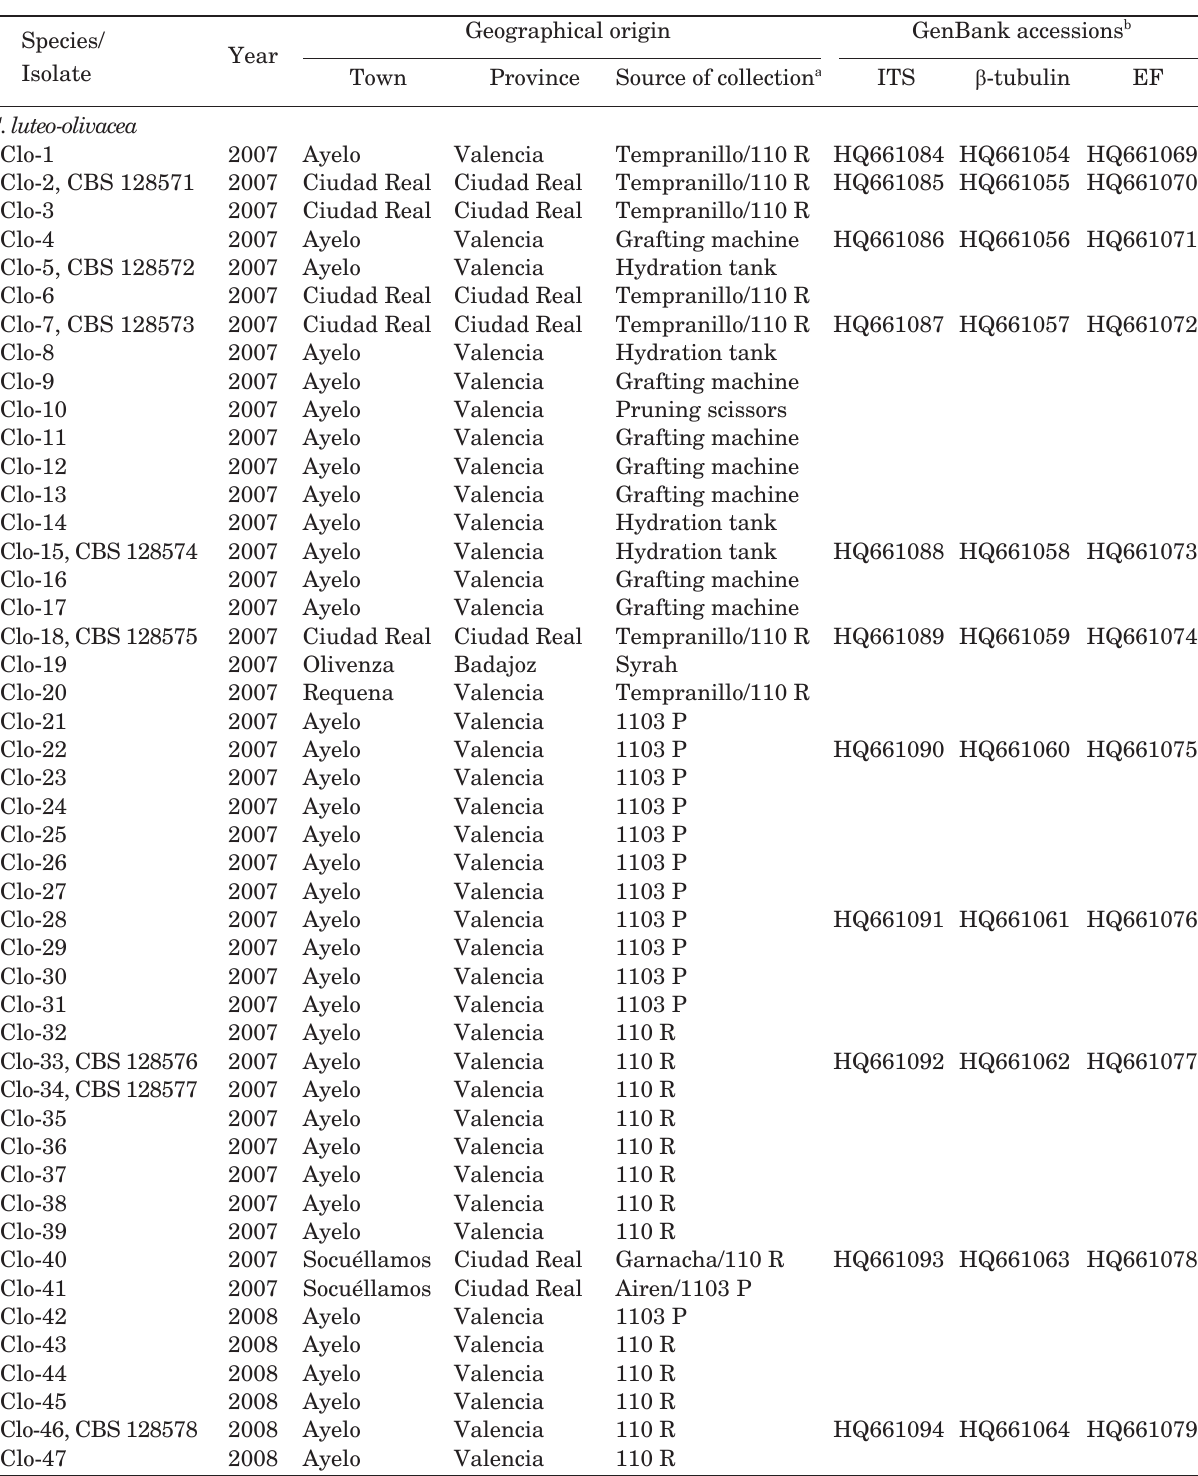
Table 1. Isolation details and GenBank accession numbers of the Cadophora isolates